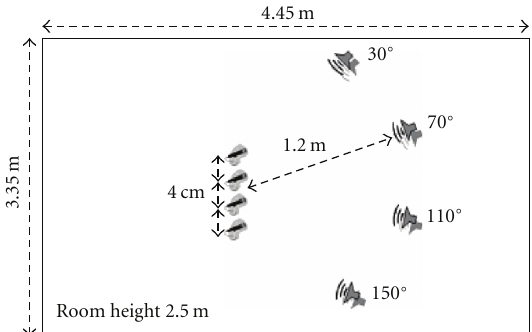
Figure 2: Configuration of the sources and microphones (repro- duced based on